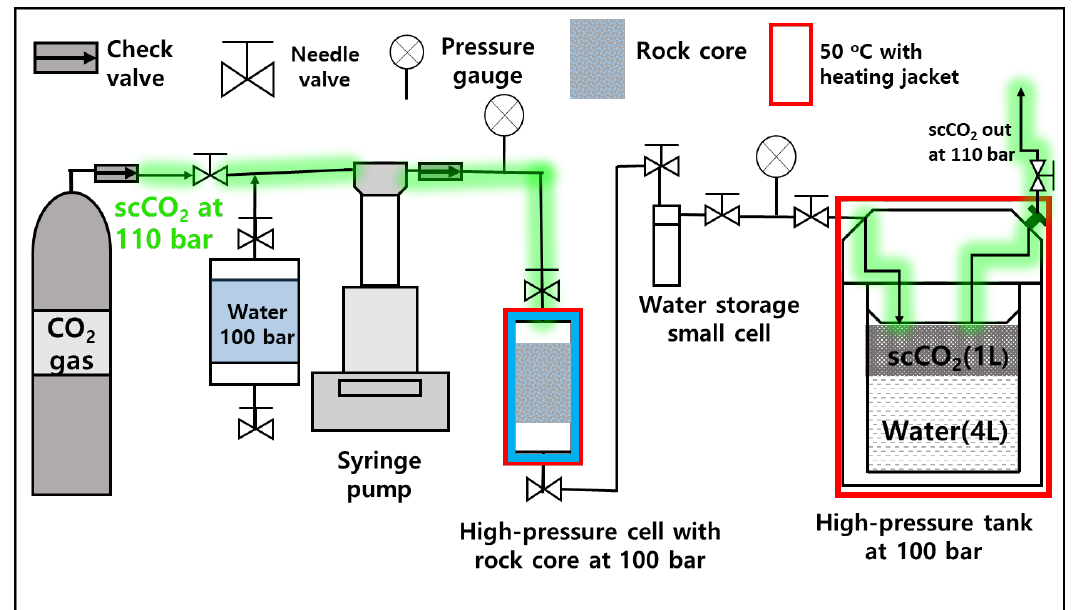
Figure 3. Schematic of the experiment to measure the scCO 2 storage ratio.